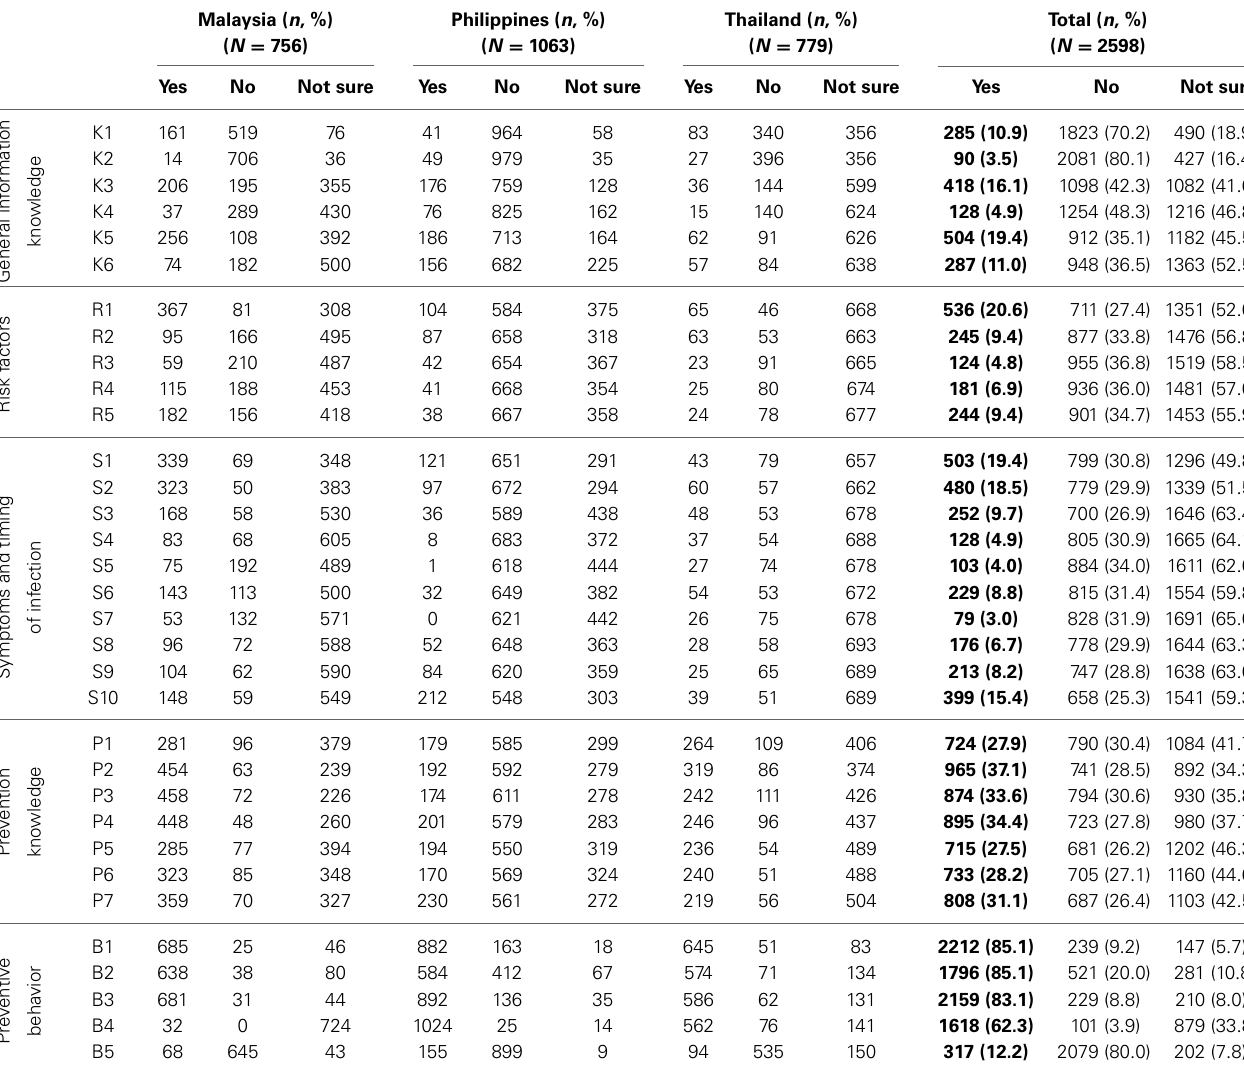
Table 2 | Pregnant women responses for knowledge and practice on Toxoplasmosis by